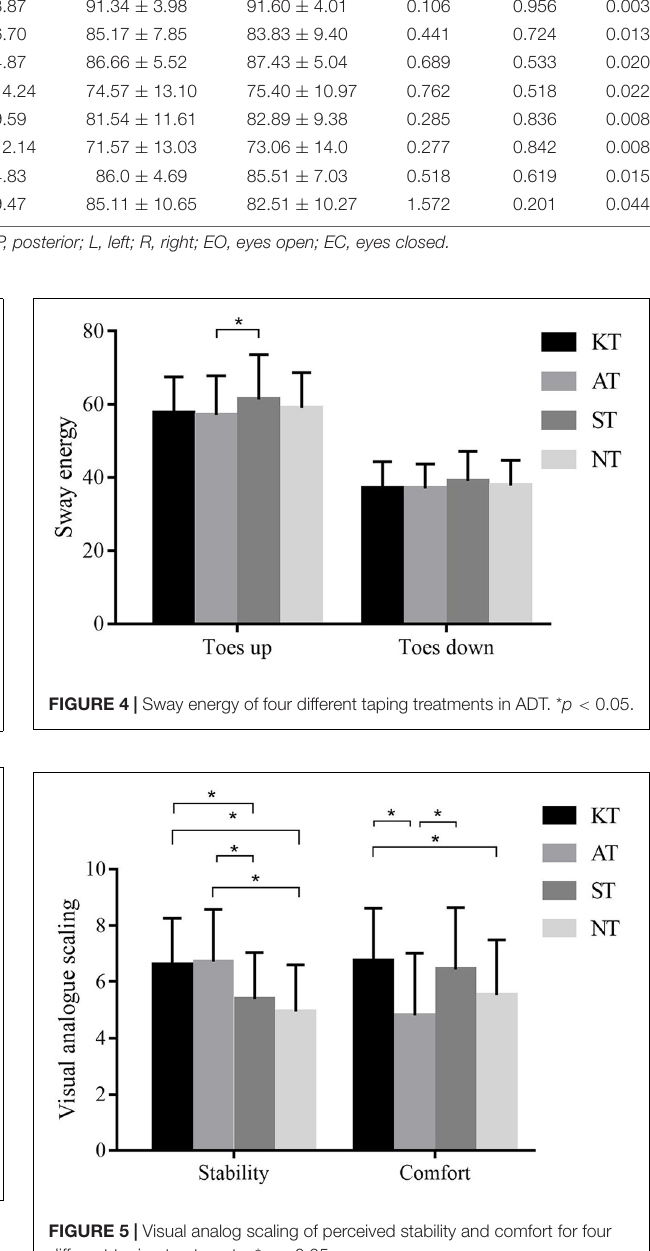
( p < 0.001, 95% CI = 0.696–2.852). For perceived comfort,